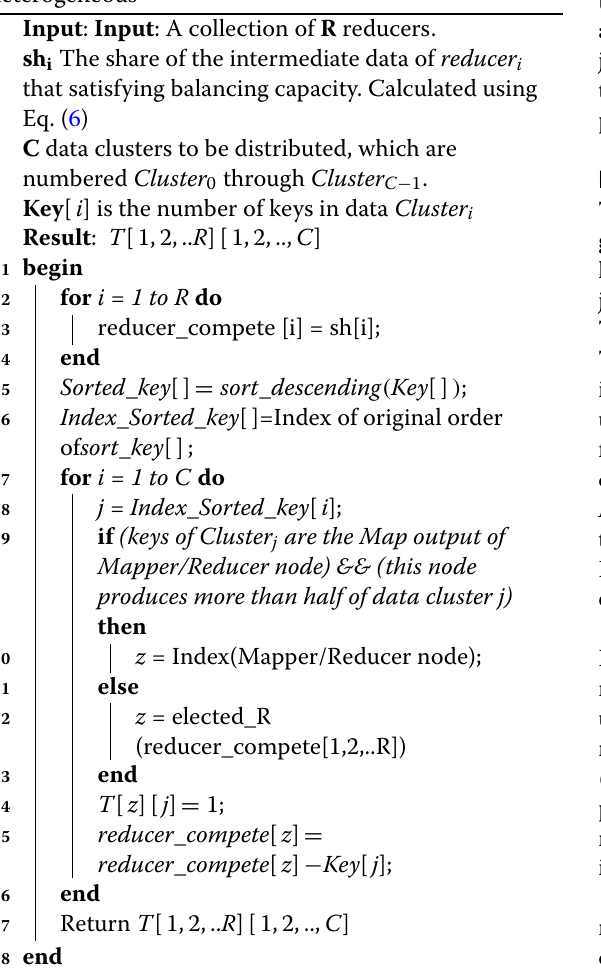
Algorithm 3: Data clusters assignment algorithm-